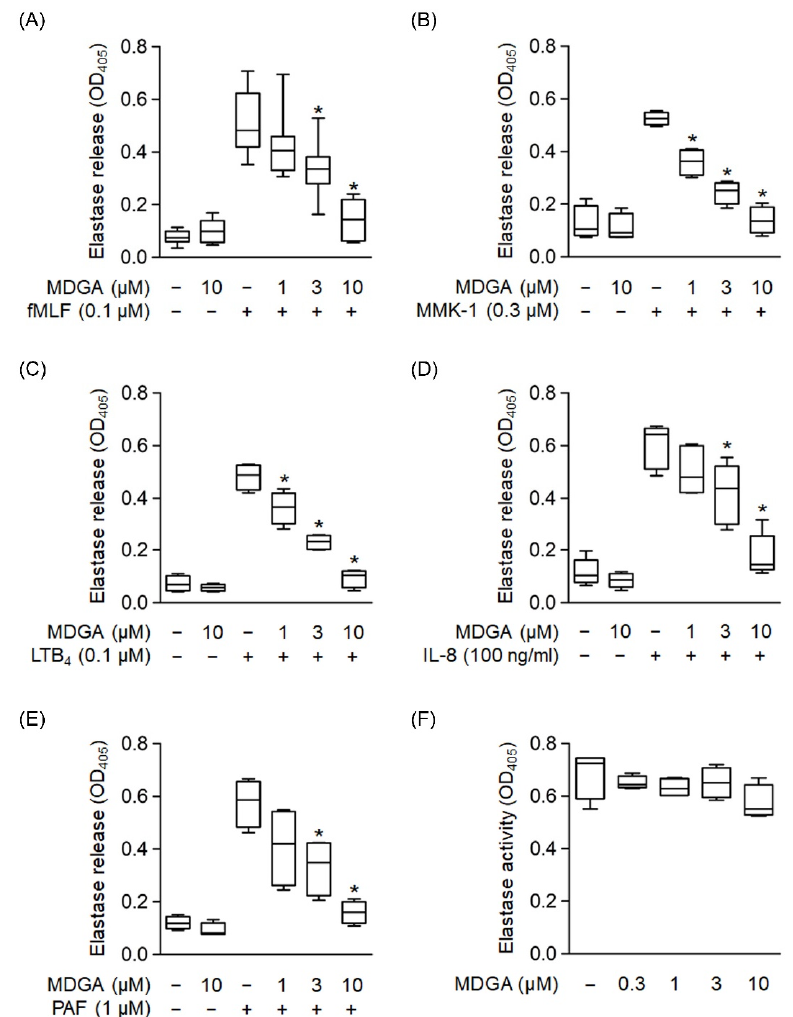
Figure 4. meso -Dihydroguaiaretic acid (MDGA) suppresses elastase release from stimulated human neutrophils. Human neutrophils were prepared with DMSO (0.1%) or MDGA (1, 3, and 10 µ M) and then activated by ( A ) fMLF (0.1 µ M) + CB (0.5 µ g/mL), ( B ) MMK-1 (0.3 µ M) + CB (0.5 µ g/mL), ( C ) leukotriene B 4 (LTB 4 , 0.1 µ M) + CB (0.5 µ g/mL), ( D ) interleukin-8 (IL-8, 100 ng/mL) +